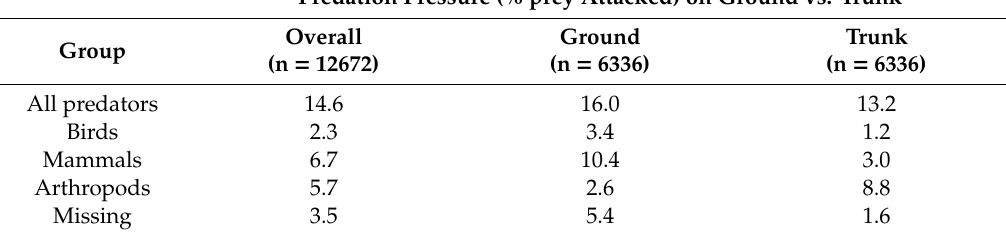
Table 2. Predation pressure by di ff erent predator groups Predation Pressure (% prey Attacked) on Ground vs. Trunk